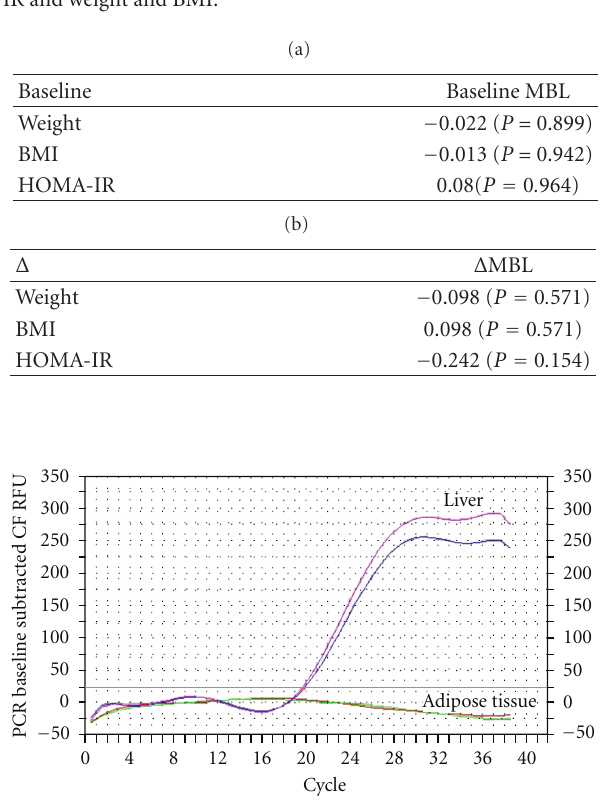
Table 2: (a) Correlations (Spearman’s rho) between baseline MBL and baseline weight, BMI and HOMA-IR. (b) Correlations (Spear- man’s rho) between change ( Δ ) in MBL and change ( Δ ) in HOMA- IR and weight and BMI.